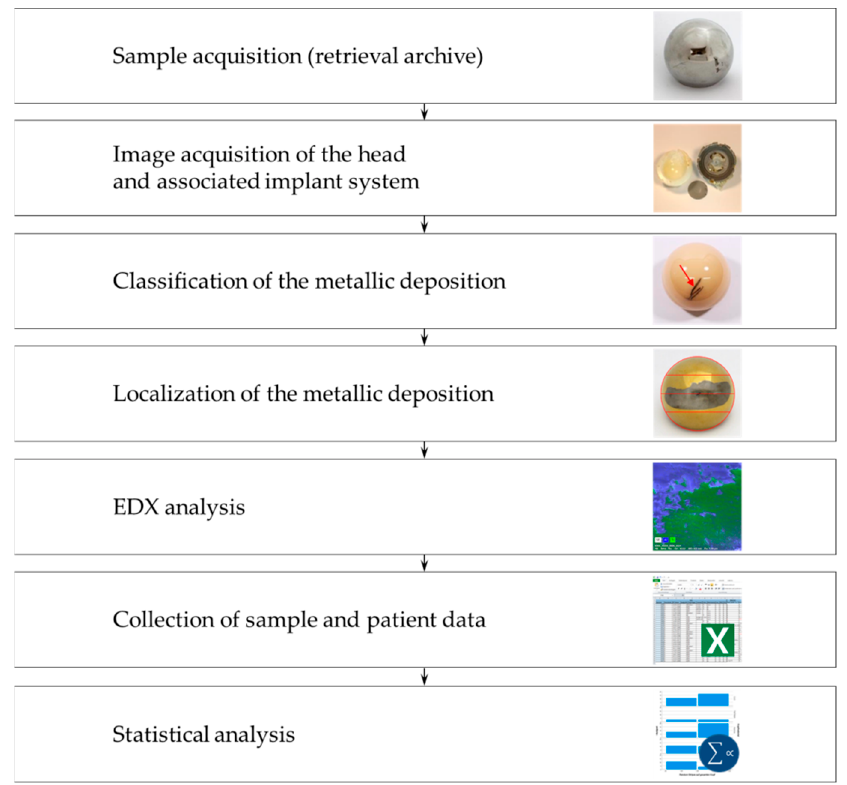
Figure 1. Workflow of the present study.